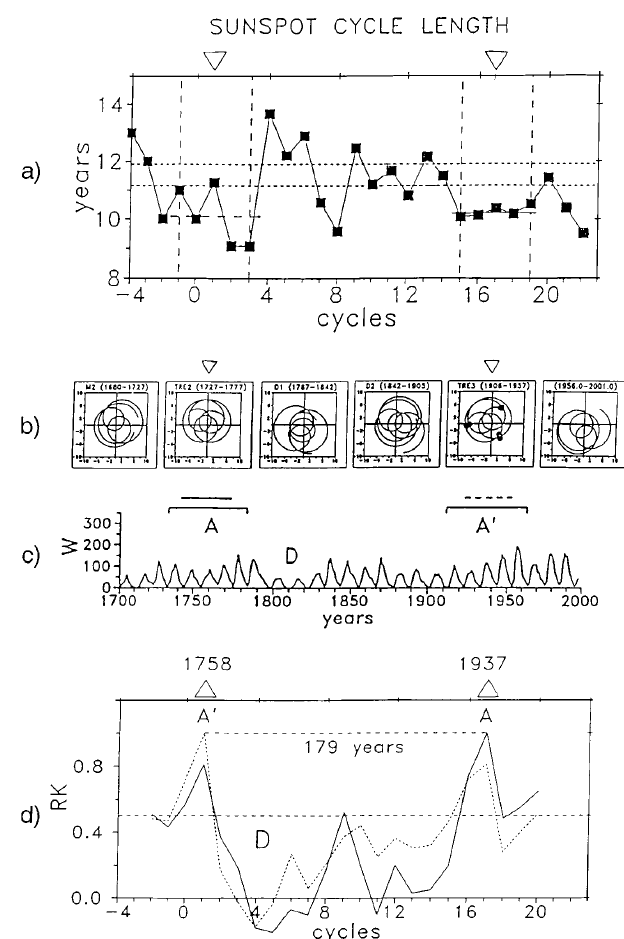
Fig. 3a–d. This figure summarizes the results obtained for solar motion – solar activity relation around the latest basic 178.7-year cycle. a The lengths of sunspot cycles since AD 1700: notice a constant cycle length equal to 10 (JS/2) years during the trefoil interval 1913– 1964 (taken from minimum to minimum). During the previous trefoil interval (1734–1785) the cycle lengths cannot be calculated more precisely (see text). However, the mean value of cycle lengths is also 10 years there. In the surrounding and intermediate intervals, the cycle lengths are variable and mostly greater. b The solar orbit from AD 1680 to 2001 in sections of 50–65 years. Two trefoil intervals are denoted by the triangles . The black circles denote the positions of the sunspot cycle maxima. c The Wolf sunspot numbers since AD 1700. The letter A ( A ¢ ) denotes the trefoil interval of the eighteenth (twentieth) century. d Coe(cid:129)cients of correlation between the series of five sunspot cycles that occurred during the trefoil intervals [1734– 1785 ( A ) and 1913–1964 ( A ¢ )] and the successive groups of five sunspot cycles in steps of one cycle since 1700. The only significant coe(cid:129)cient ( r = 0.81) is that between the groups of five cycles k belonging to the trefoil intervals. The letter D denotes the